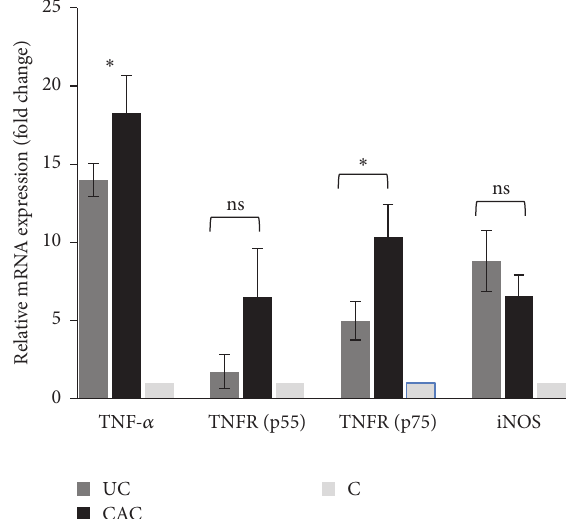
Figure 2: Messenger-RNA (mRNA) transcripts of TNF- 𝛼 , TNFR (p55, p75), and iNOS were quantitated in colonic mucosa of patients with UC and CAC. Expression was normalized against 𝛽 -actin and GAPDH housekeeping gene, and relative expression was represented data as fold differences by the 2 −ΔΔ Ct method, where Δ Ct = Ct target gene − Ct MG and ΔΔ Ct = Δ Ct inflamed colonic mucosa − Δ Ct normal colonic mucosa. Fold changes were calculated using the comparative Ct method. Data represent mean ± standard deviation. Significant difference between the two groups of patients (UC/CAC) is indicated ( ∗ 𝑃 < 0.05 ). ns, no significant difference, 𝑃 > 0.05 (UC, ulcerative colitis, 𝑛 = 12 ; CAC, colitis associated cancer, 𝑛 = 5 ; C, control, 𝑛 = 5